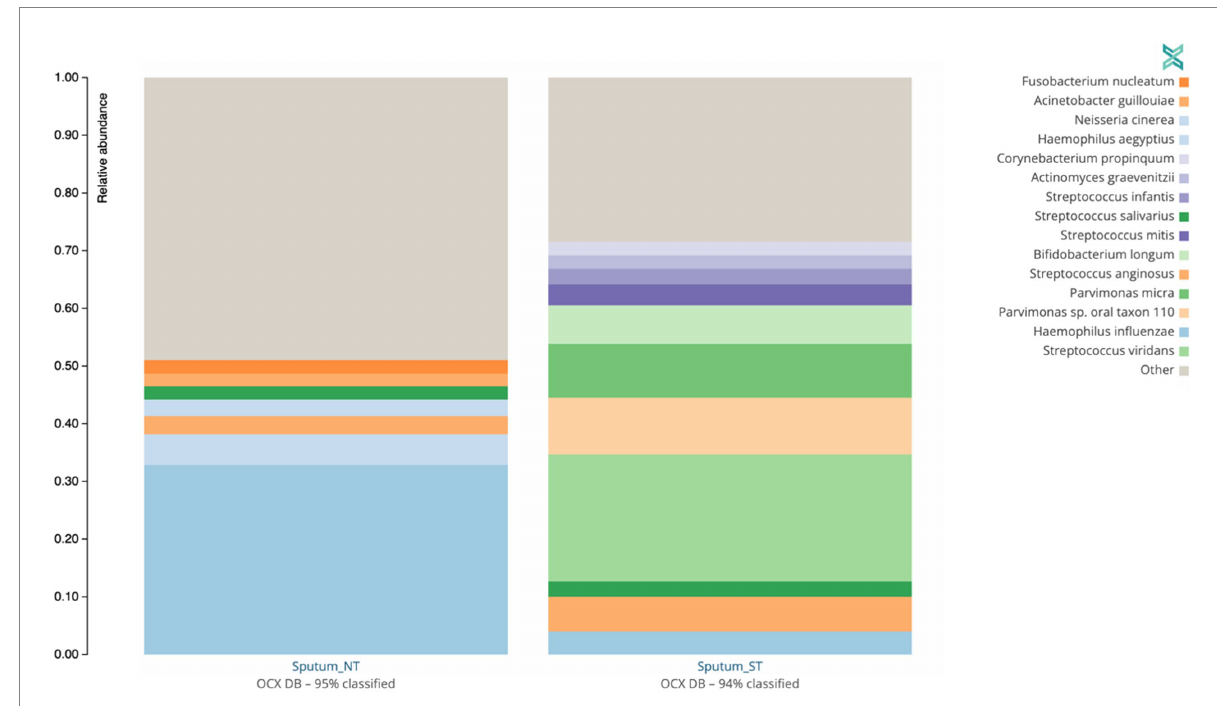
FIGURE 6 Effect of saponin treatment (ST) on microbiota present in patient sputa. Non-spiked sputa (A) and sputa spiked (B,C) with different concentrations of M. abscessus (high: 2.02 × 10 8 CFU/ml, med: 2.02 × 10 7 CFU/ml, low: 2.02 × 10 6 CFU/ml). Subsequently, sputa were incubated (ST) or not (NT) with saponin followed by DNAse treatment. Relative abundance of bacterial genera (A,B) or species (C) with at least 2% reads are shown. Other refers to low abundant